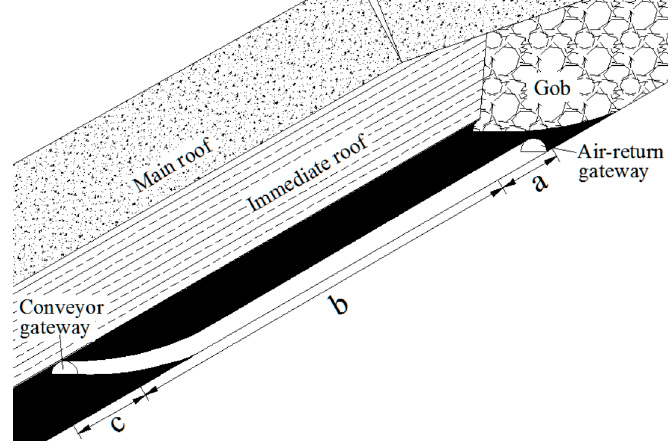
Figure 4. Triple sections mining technology (TSMT) of LMSG.